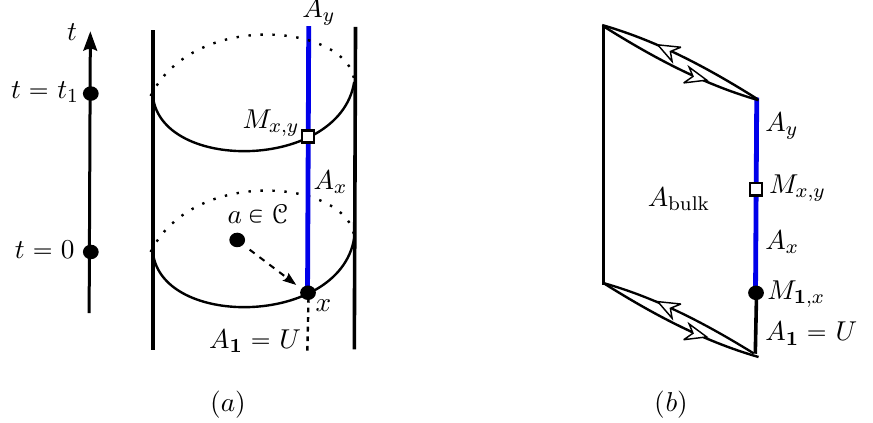
Figure 5 . The picture (a) depicts a 2d topological order p C ; c q on a 2-disk, together with a 1d gapless edge, propagating in time. At t (cid:16) 0, a topological edge excitation x is created. At t (cid:16) t 1 ¡ 0, the edge excitation is changed to y . This change creates a domain wall M x;y between OSVOA’s A x and A y . The picture (b) depicts the 1+1D world sheet obtained by squeezing the picture